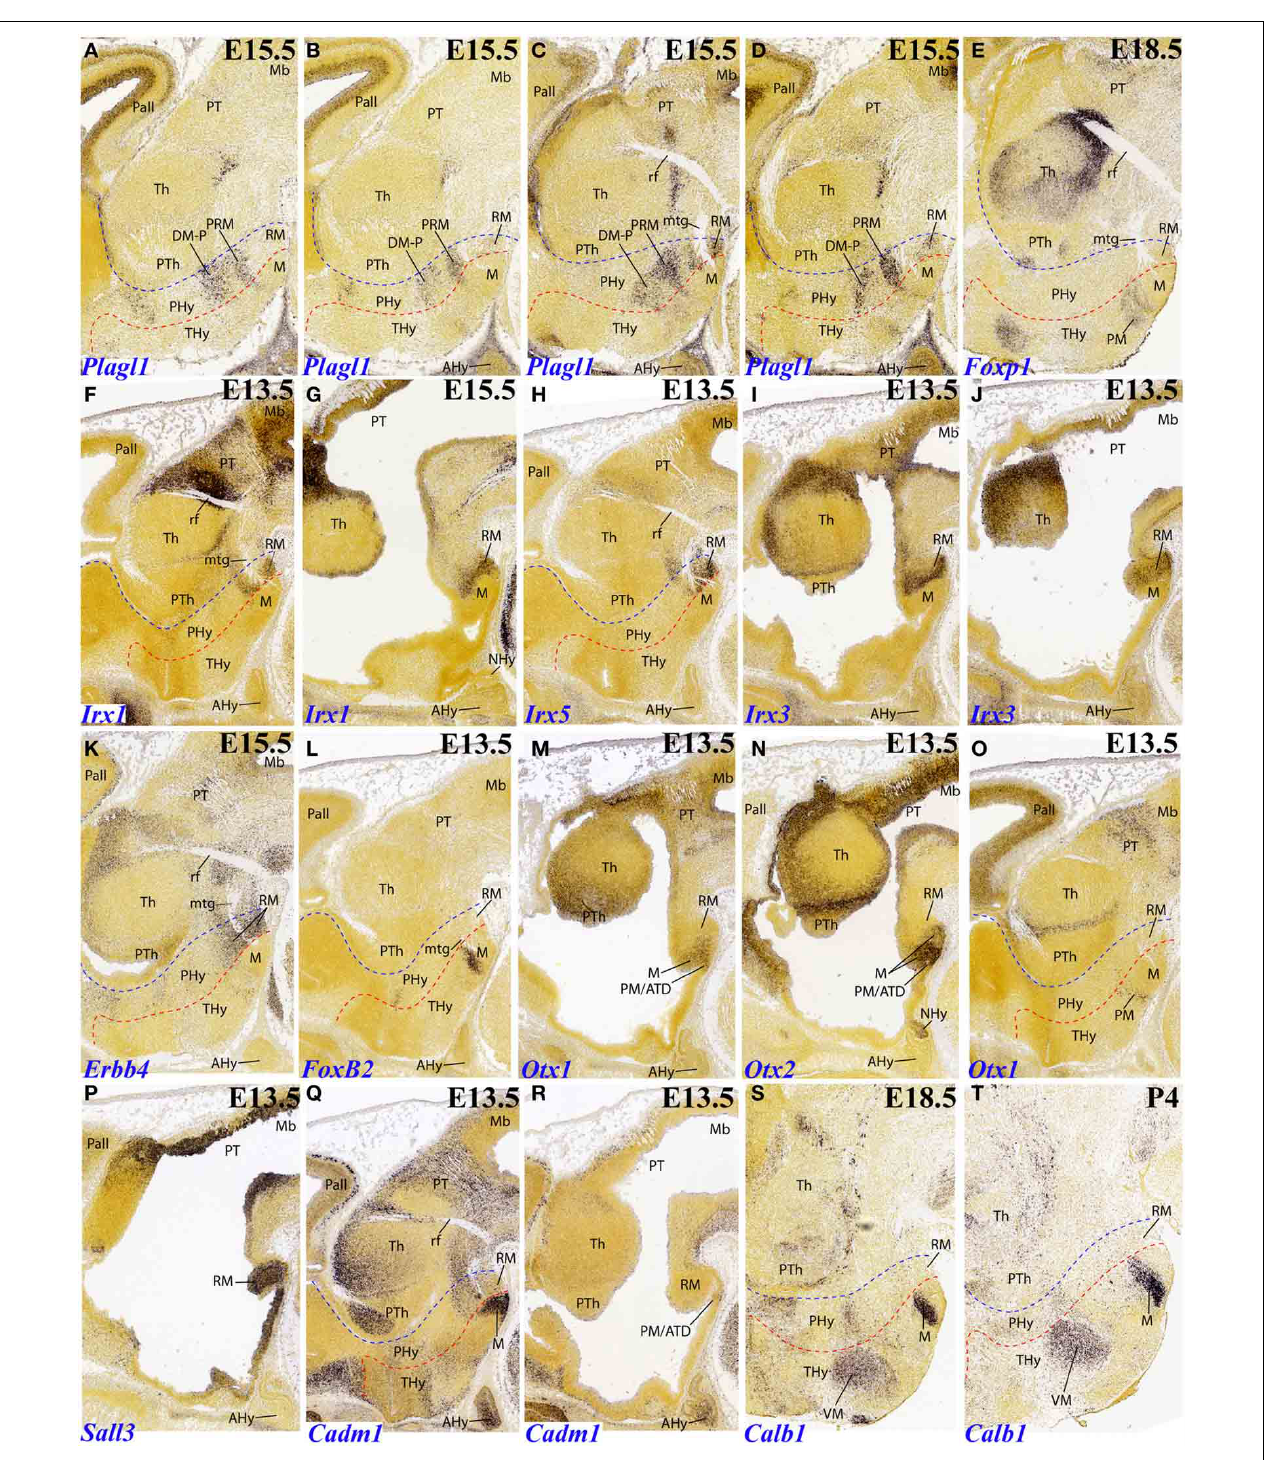
FIGURE 5 | Sagittal and parasagittal (A–T) sections through the mouse secondary prosencephalon and diencephalon at E11.5, E13.5, E15.5, E18.5, and P4, showing relevant examples of hypothalamic genes expressed selectively at the terminal (THy), peduncular (PHy) or acroterminal (ATD) territories: Plagl1 (A–D), Foxp1 (E), Irx1 (F,G),